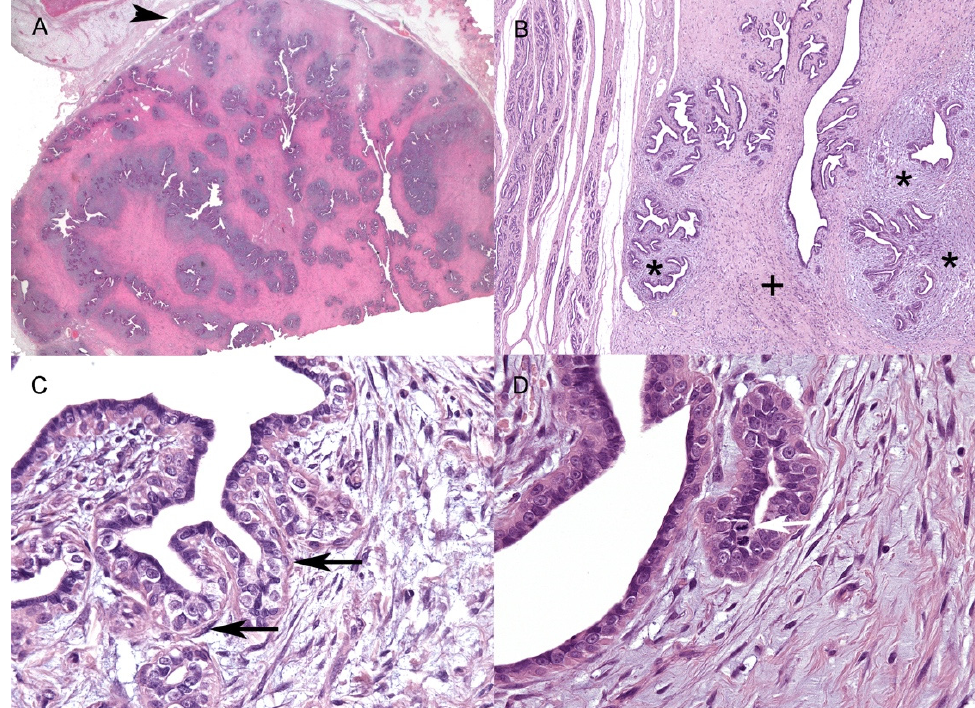
Figure 1. Histopathological features of feline mammary fibroadenoma. ( A ) Well-defined subcutaneous fibroadenoma with adjacent unaffected mammary gland (arrowhead) (size of the nodule at histology: 4.3 × 2.1 cm) (HE, 2×); ( B ) Unaffected mammary gland (on the left) and the lesion showing an elongated duct (centre of the lesion) and lobular-like structures. A more densely cellular, myxomatous intralobular stroma (asterisks) and a more collagenous, poorly cellular interlobular (+) stroma are evident (HE, 4×); ( C ) Elongated basally located cells (arrows), compatible with myoepithelial cells surrounding the irregularly polygonal epithelial cells (HE, 40×); ( D ) Frequent mitoses are present mainly within the neoplastic epithelial population (white arrow) (HE, 40×). HE = haematoxylin and eosin.